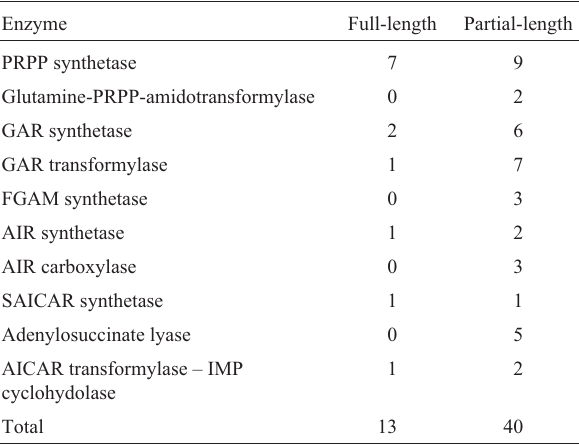
Table II - Frequency of full-length EST